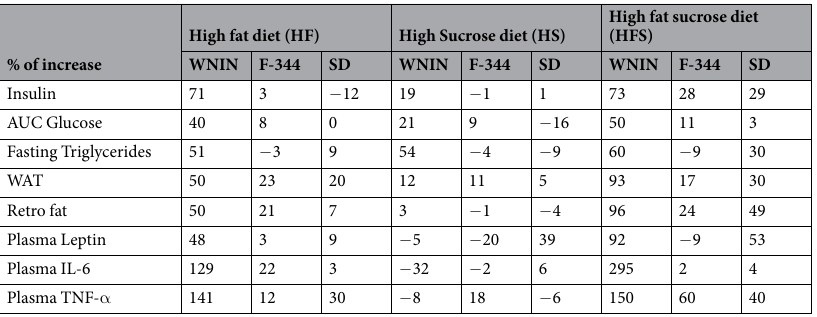
Table 2. Assessment of effect of individual high calorie diets towards obesity development in WNIN, F-344 and SD. The data was presented as the percentage change to their respective control groups. Data was normalized against to their respective control groups after obtaining statistical mean values for the each parameter and measured the percent of change by calculating {(experimental − control)/control} * 100 and represented the values as increased or